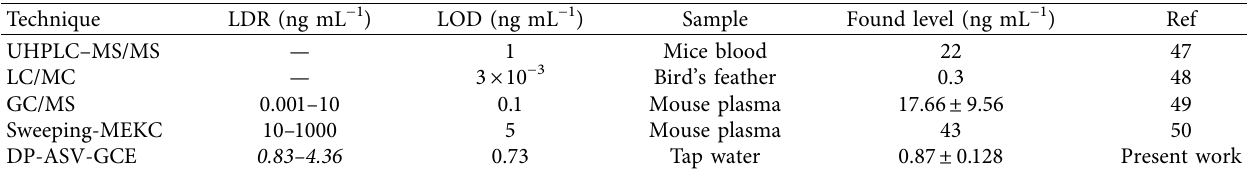
Table 1: Comparison between the analytical features of the established DP-ASV and some of the published chromatographic and electrochemical methods ∗ .